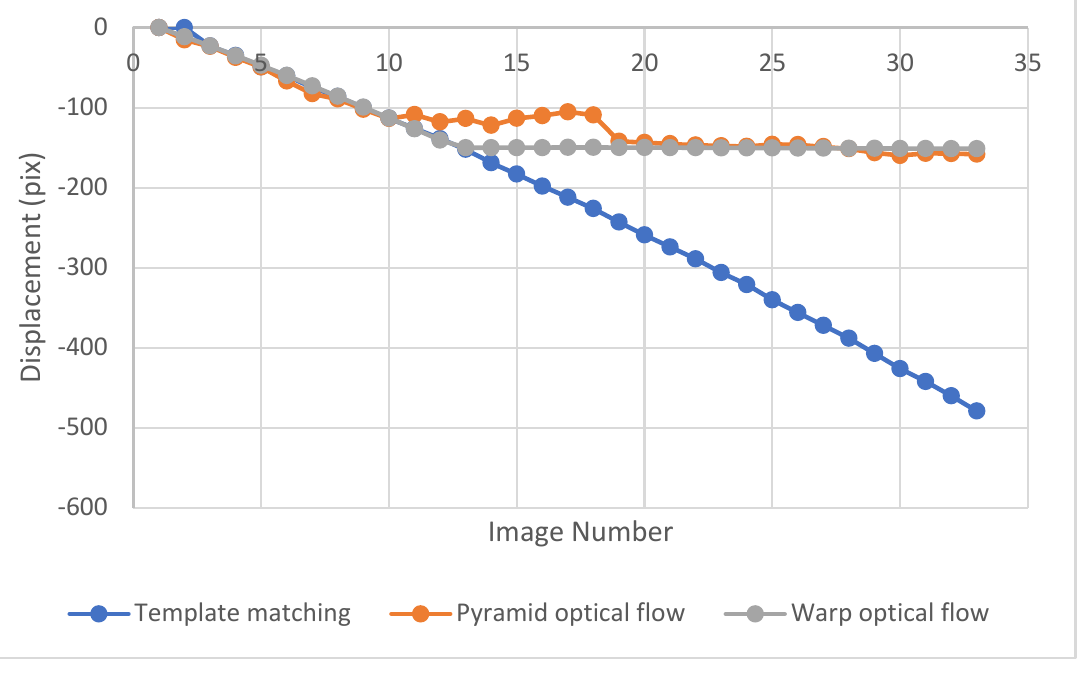
Figure 8. Displacement of a free-falling aggregate obtained using the pyramid and warp LK optical flow, compared with the displacement obtained using the template matching method.